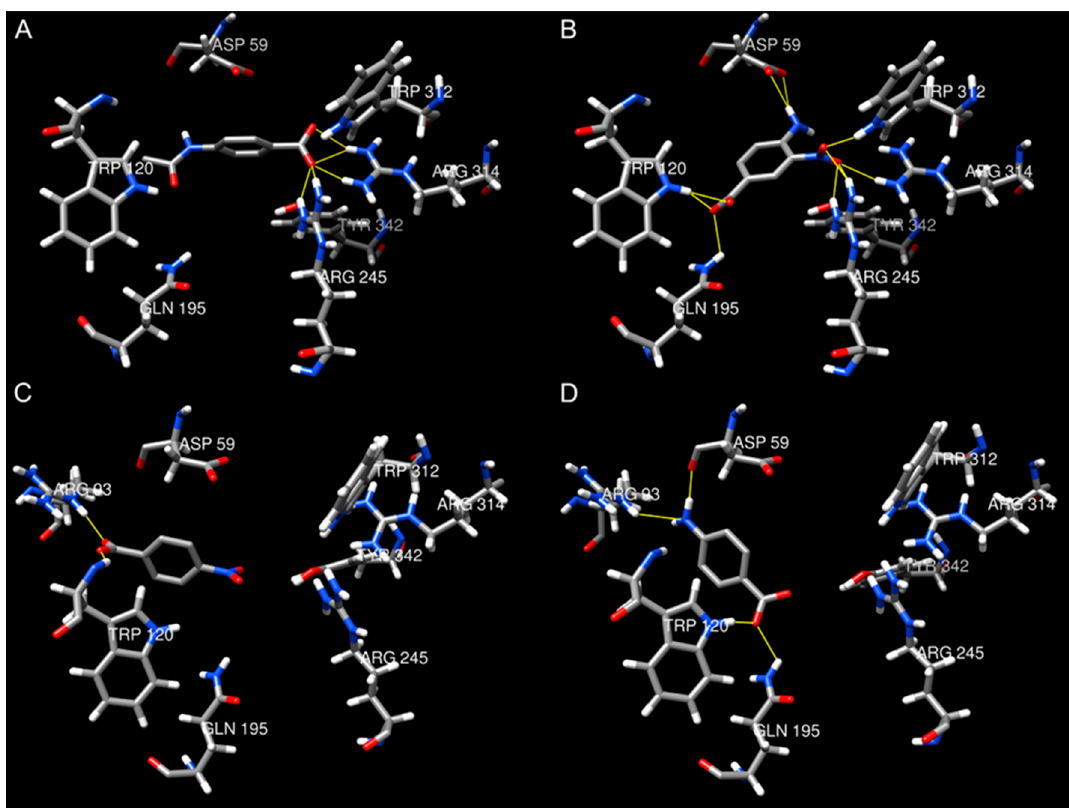
Figure 6. Best-scored conformations and interactions of selected compounds with TcTS. ( A ) compound 24 in binding mode A; ( B ) compound 16 in binding mode A2; ( C , D ) compounds 13 and 10 in binding mode B, respectively.